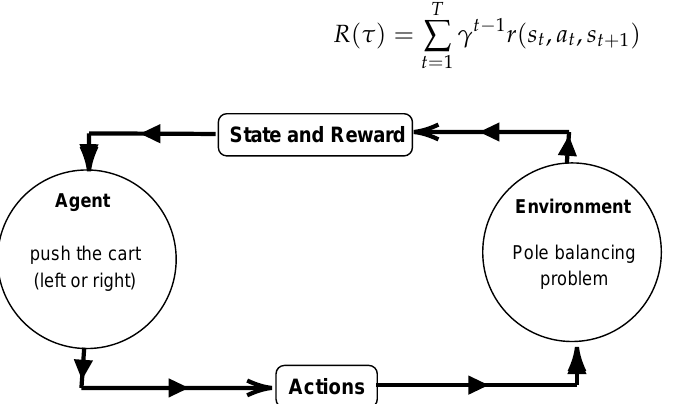
Figure 2. Simplified outline of the pole balancing problem in the RL